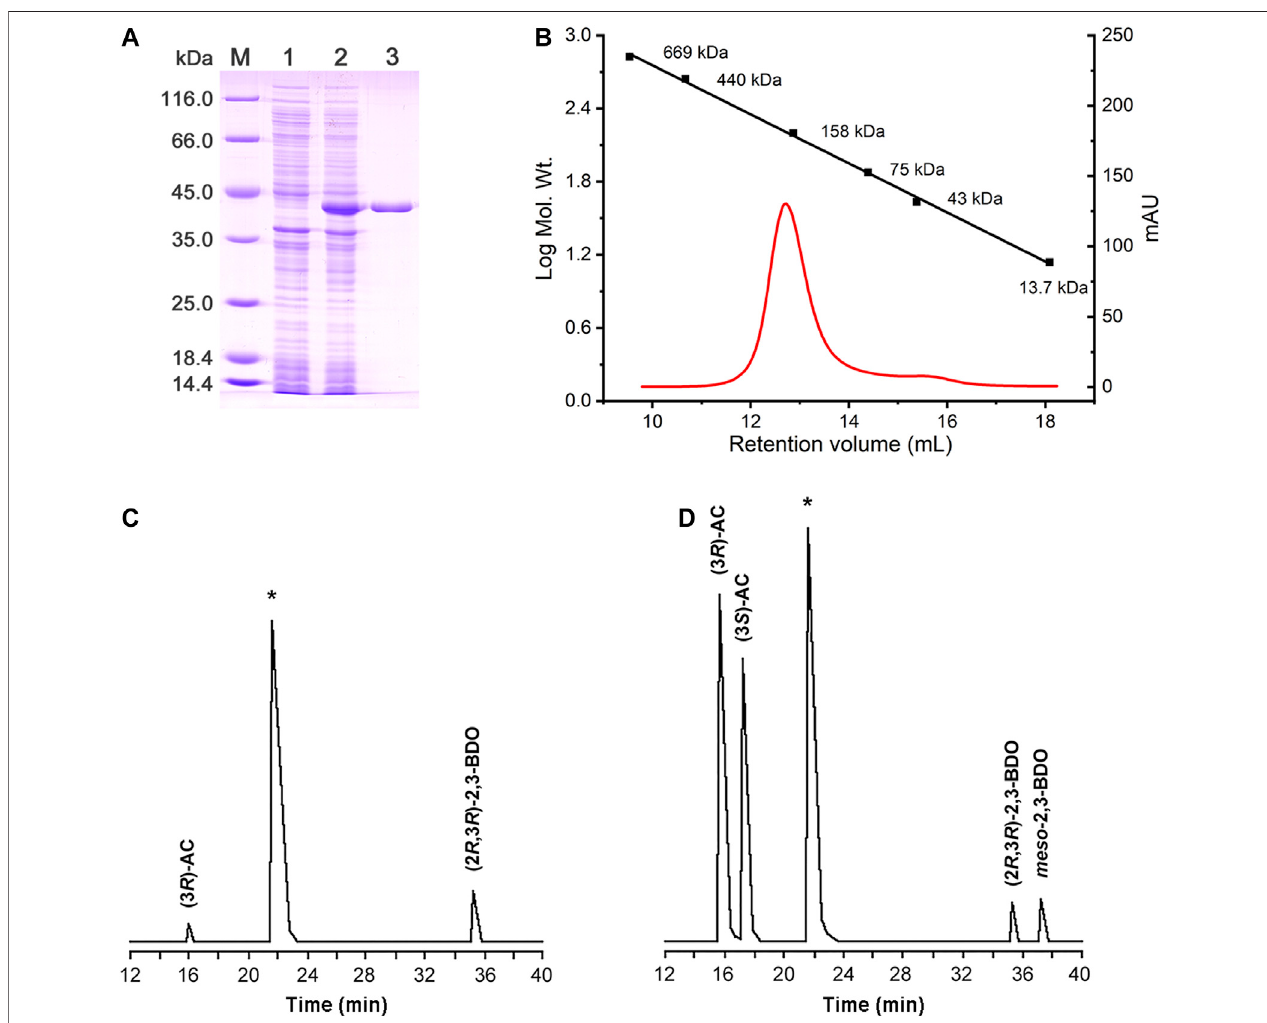
FIGURE3| Enzymaticcharacterizationof R , R -BDHin P.putida KT2440. (A) SDS-PAGEanalysisofthepuri fi ed R , R -BDH.LaneM,molecularweightmarkers;Lane 1, crude cell extract of E. coli BL21 (DE3) (blank control); Lane 2, crude cell extract of E. coli BL21 (DE3) harboring pETDuet- pp0552 ; Lane 3, puri fi ed R , R -BDH. (B) Determination ofthenative molecular weightof R , R -BDH bygel fi ltration column. GCanalysisof2,3-BDO produced by R , R -BDH catalyzedreductionofdiacetyl (C) and racemic AC (D) .